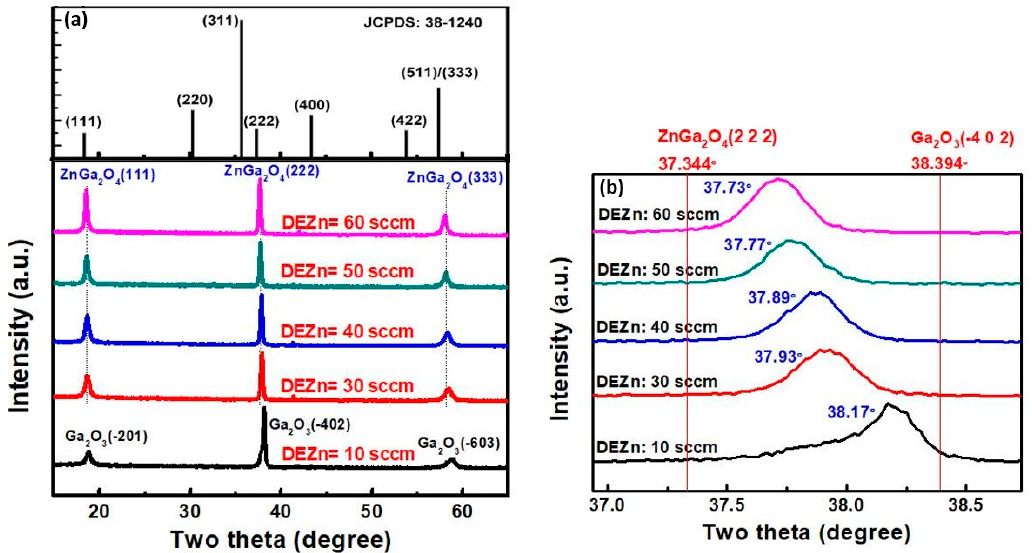
Figure 17. ( a ) XRD patterns of ZnGa 2 O 4 films prepared at various DEZn flow rates of 10 − 60 sccm and ( b ) XRD patterns of ZnGa 2 O 4 films prepared at various DEZn flow rates of 10 − 60 sccm with the limited 2 θ range from 36.9° to 38.7° [76] (with copyright permission from American Chemical Society, 2020). Joint Committee on Powder Diffraction Standards (JCPDS) data of the normal spinel ZnGa 2 O 4 (card no. 38-1240) is given for reference.